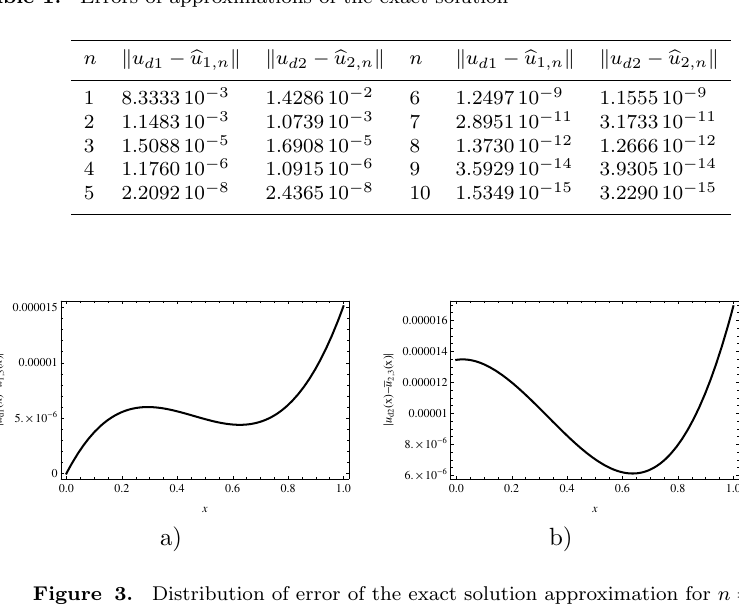
Table 1. Errors of approximations of the exact solution